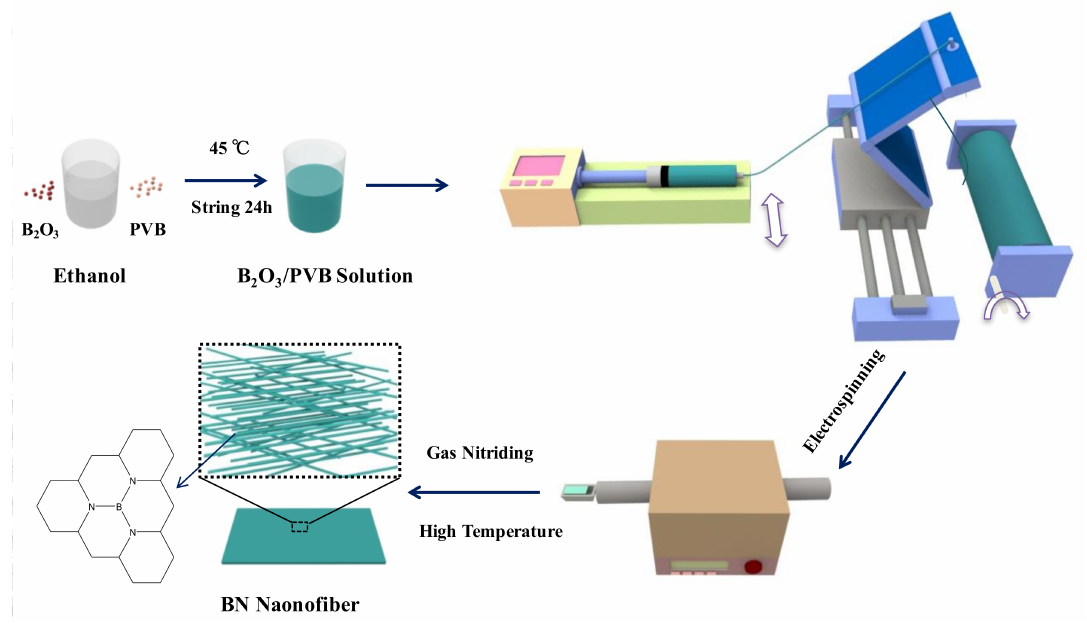
Figure 1. Schematic illustration showing the fabrication of boron nitride (BN) fiber via